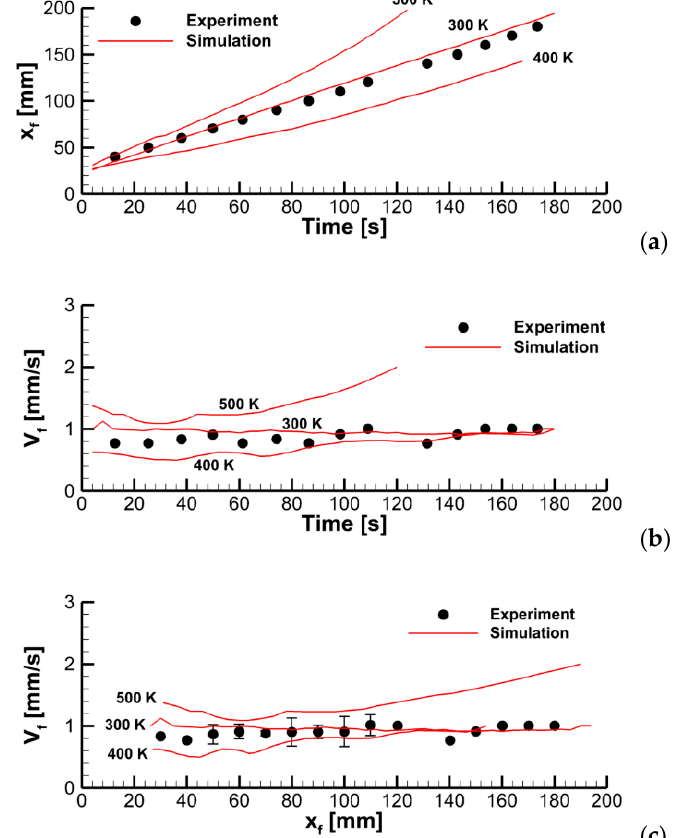
Figure 21. Dynamics of flame propagation in the axial plane: ( a )—the pyrolysis front coordinate vs. time; ( b )—front propagation velocity vs. time; ( c )—flame propagation velocity vs. pyrolysis front coordinate. Solid lines—simulations with the different values of heater temperature.